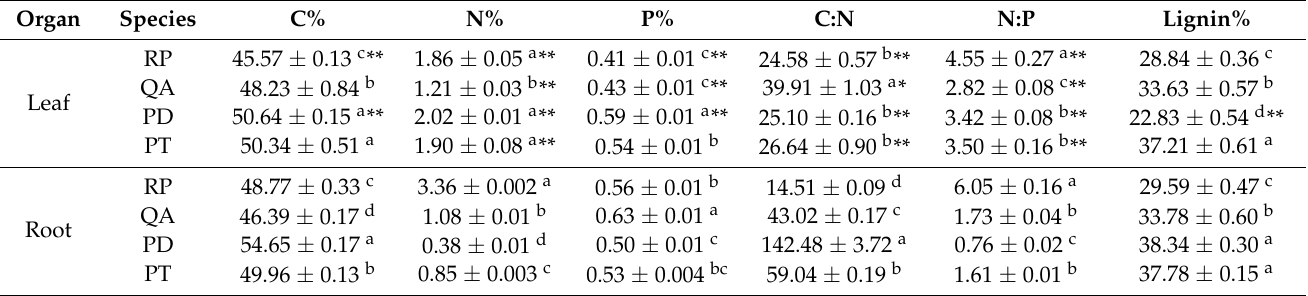
Table 2. Initial fine root and leaf litter chemistry of R . pseudoacacia , Q . acutissima , P. densiflora and P . tabulaeformis